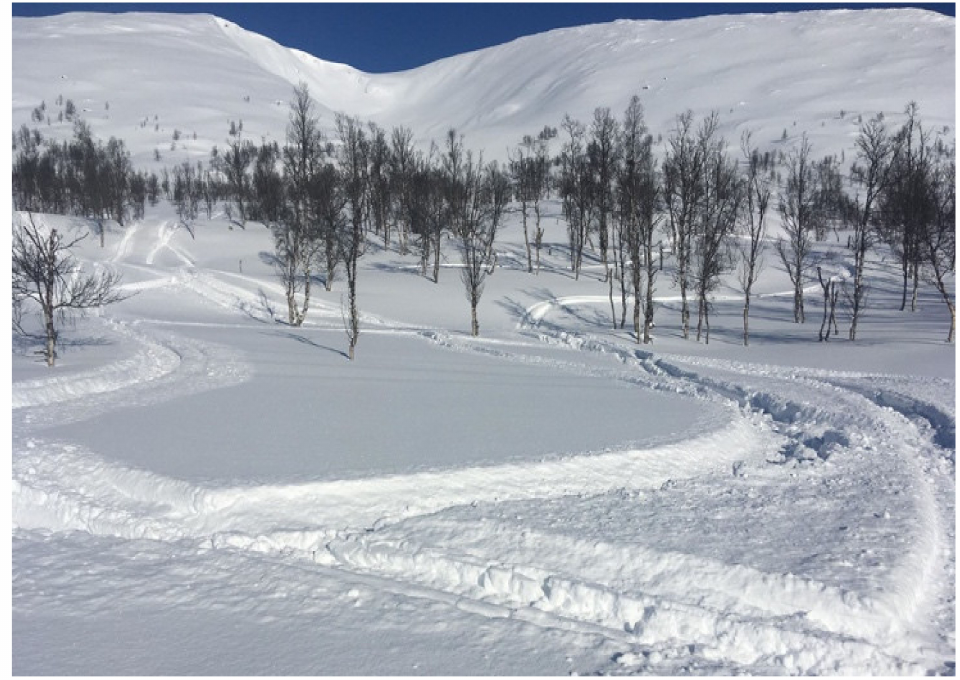
Figure 2. Technical riding tracks in the focus area between the trees. Note that there are no tracks in the classic hill climbing bowl in the background. Photo: B.